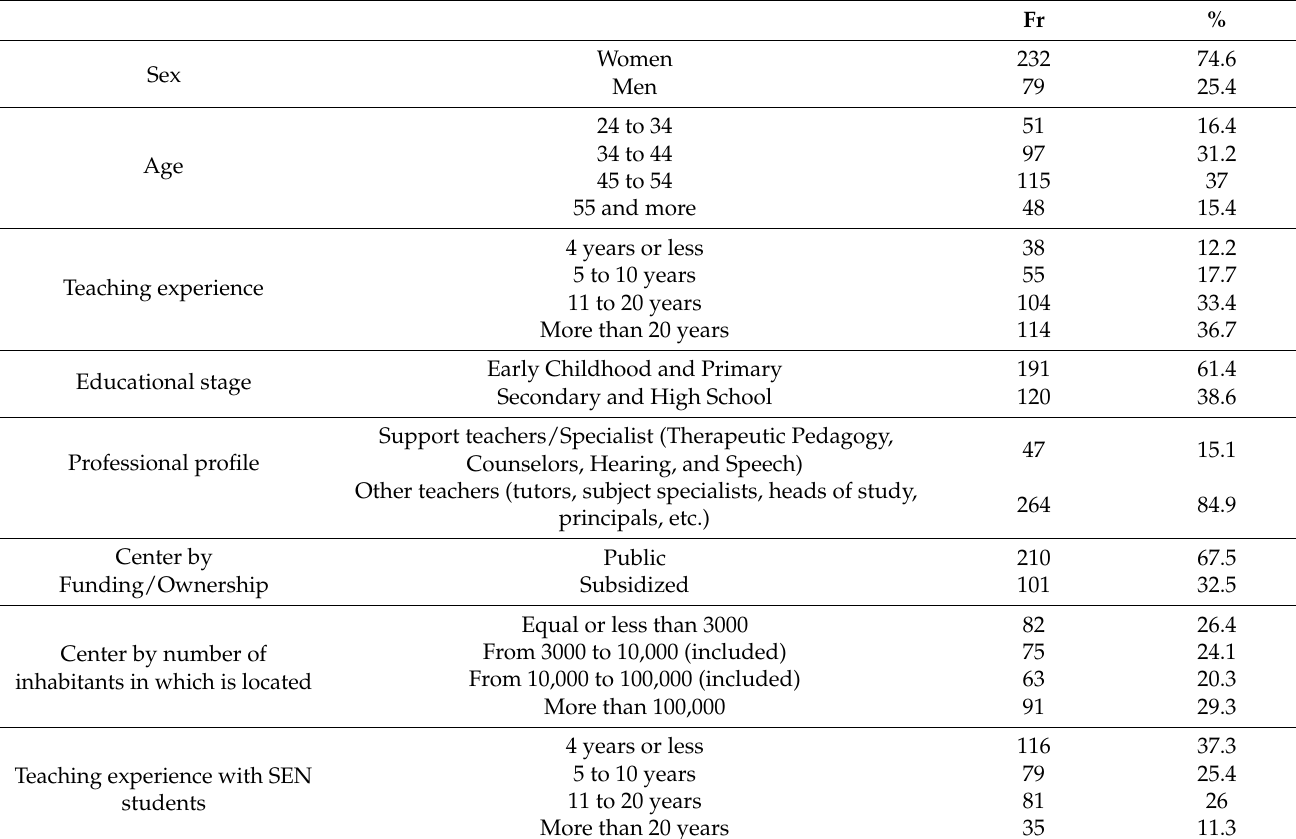
Table 3. Sample distribution. Categorization of the socio-professional variables of the sample.